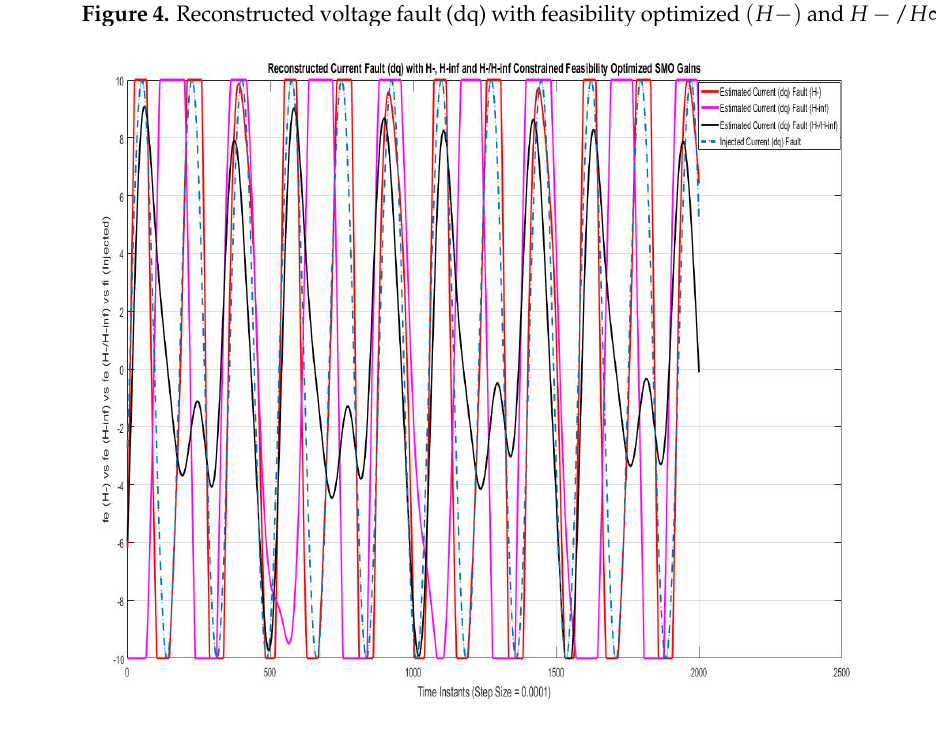
Figure 5. Reconstructed current fault (dq) with feasibility optimized H − and H − / H ∞ SMO